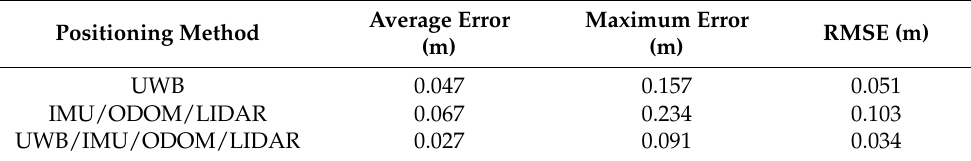
Table 2. Statistics and analysis of lateral error of different positioning methods.